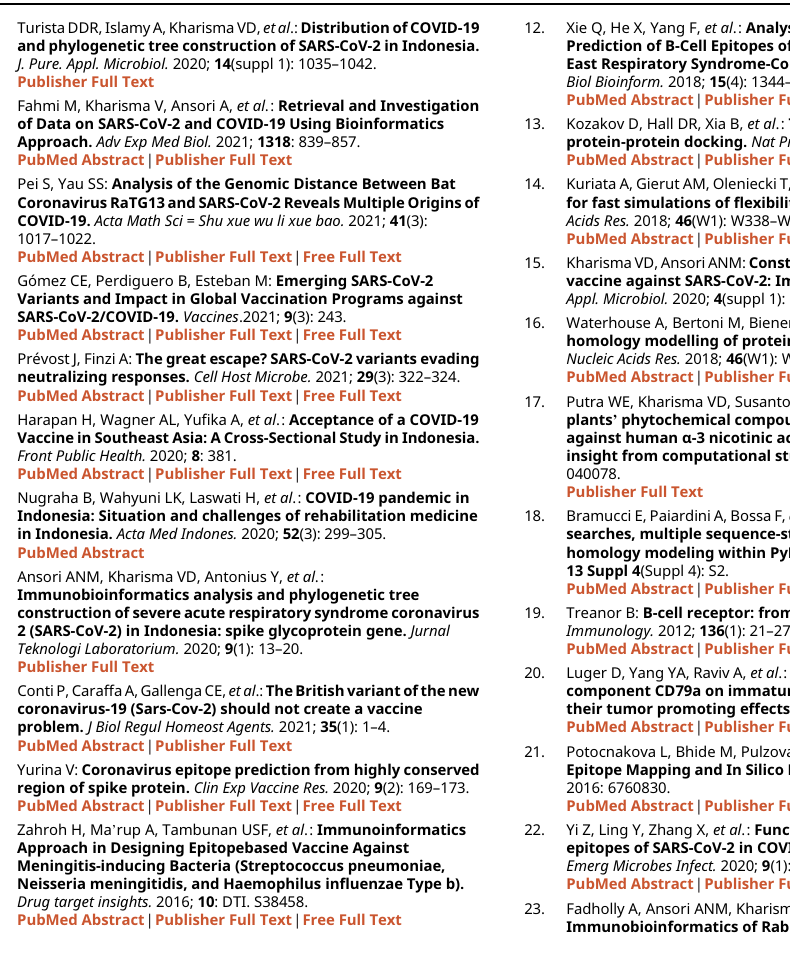
Figshare: GISAID acknowledgment table: https://doi.org/10.6084/m9.figshare.15048513.v1. 31